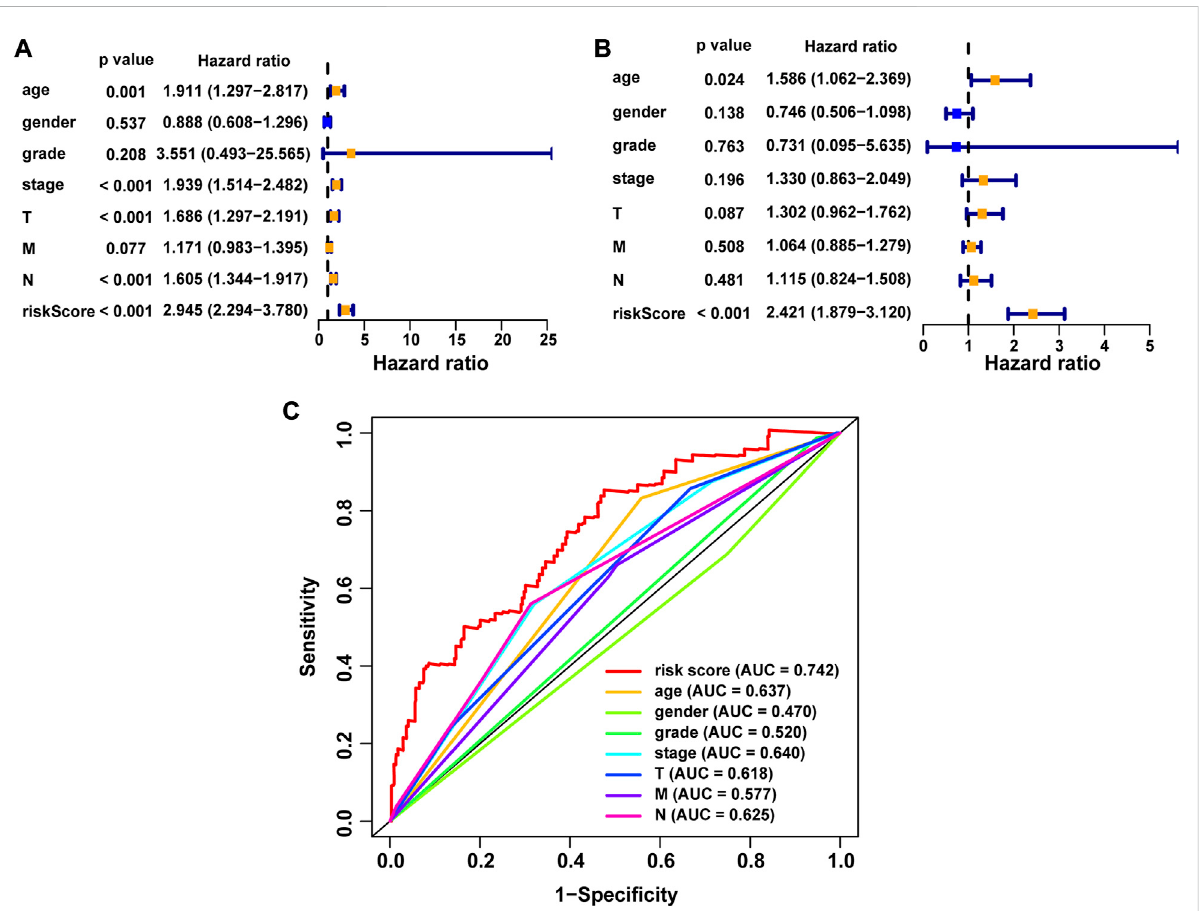
FIGURE 8 Correlation between NRG score and the prognosis of BLCA patients. (A) Forest plot for univariate Cox regression analysis. (B) Forest plot for multivariate Cox regression analysis. (C) ROC curve and AUCs of the risk score and clinicopathological variables. ROC, receiver operating characteristic; AUC, area under the curve; T, tumor; N, lymph